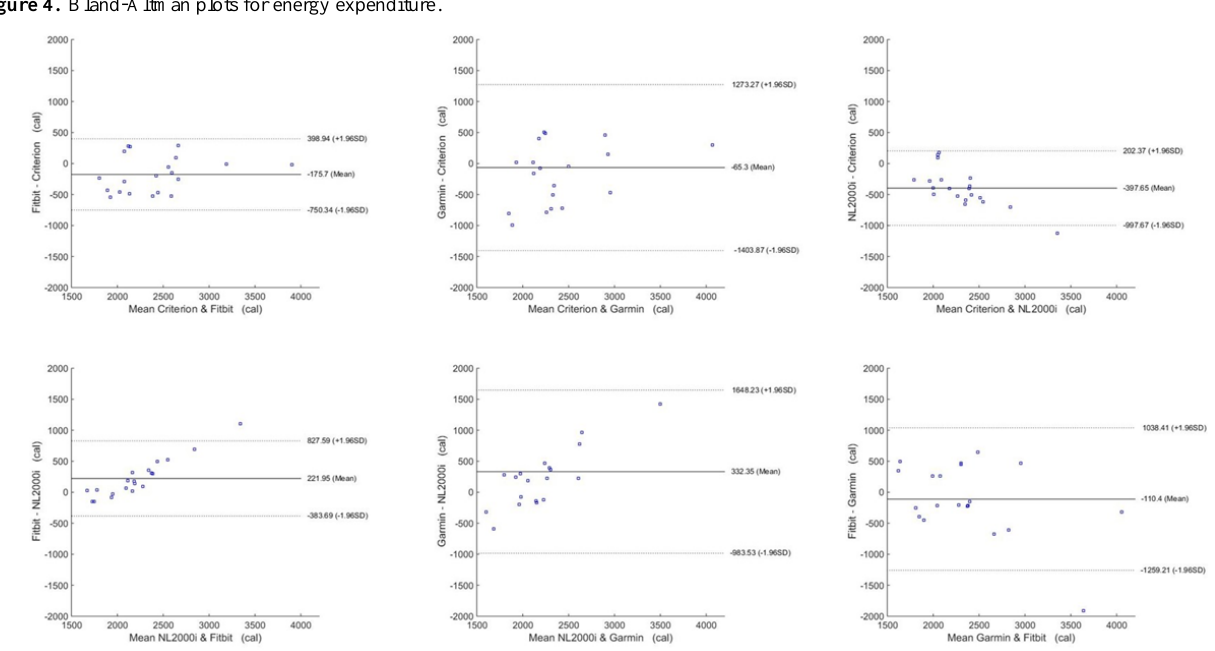
Figure 4. Bland-Altman plots for energy